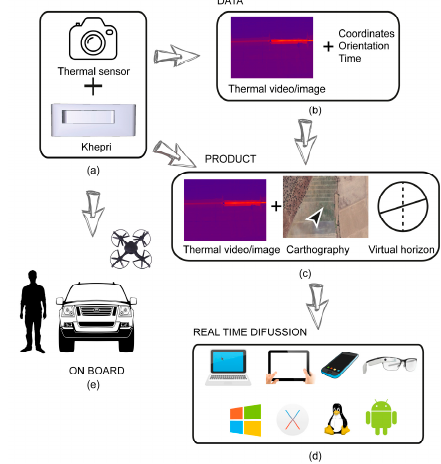
Figure 2. Conceptual model of the system: ( a ) Thermal sensor connected to the Khepri; ( b ) Data package generated by the system; ( c ) Thermal information and georeferentiation of the system over cartograph; ( d ) Real-time diffusion regardless of device and operating system and ( e ) Working onboard multiple platforms.